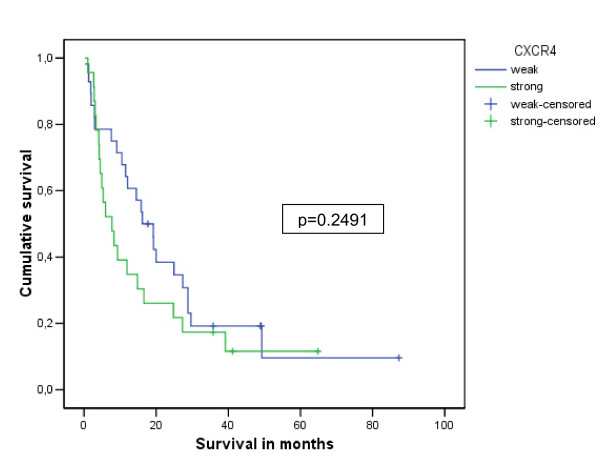
Kaplan-Meier survival curves for patients with squamous cell carcinoma and weak (CXCR4w) versus strong (CXCR4s) chemokine receptor expression.